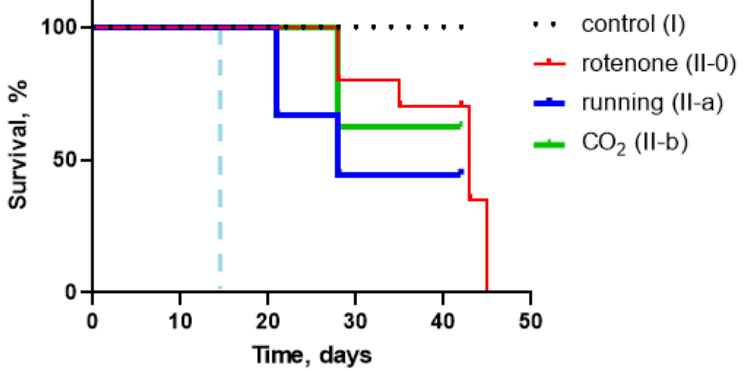
Figure 6. Survival Kaplan–Meier curves for control (I), rotenone exposed (II-0), moderate physical activity (running) treated (II-a), and CO 2 -treated (II-b). No significant differences were found between groups ( p > 0.05). The dashed blue line indicates therapy start point.